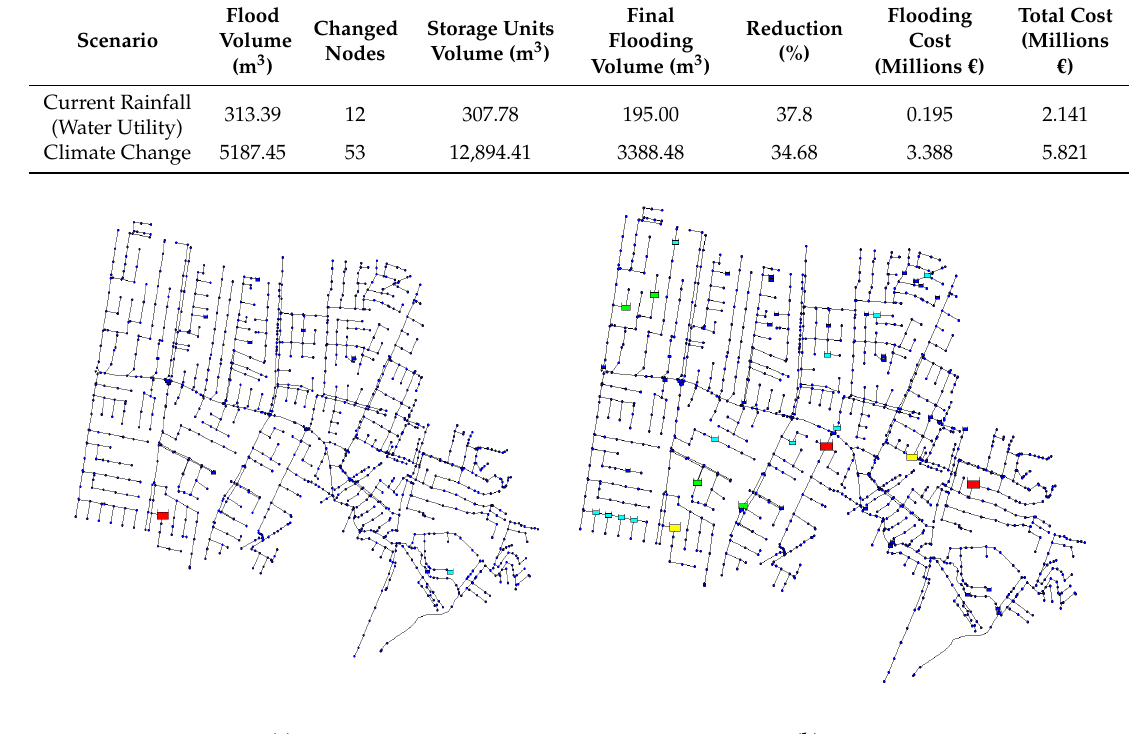
Table 4. Results for the Northern Chic ó Network using OptiTank under di ff erent rainfall scenarios.